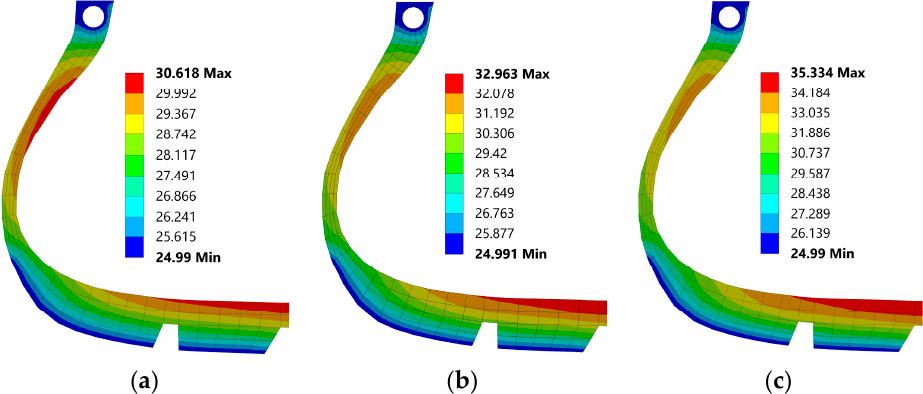
Figure 17. Distribution of temperature within rubber with different velocities (unit: ◦ C): ( a ) 40 km/h; ( b ) 80 km/h; ( c ) 120 km/h.